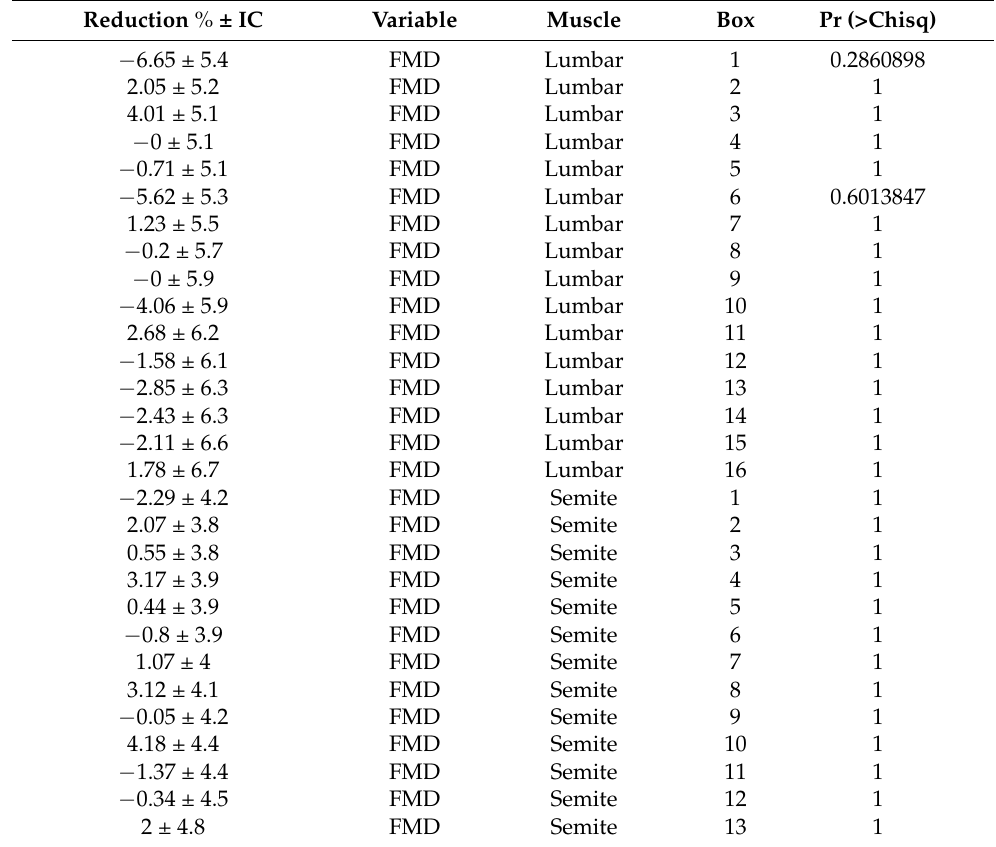
Table A5. The first column includes the percentile of reduction with the confidence interval. The second column shows the variable, in this case, the FMD; the third column, the muscle; and the fourth column, the number of box. Last value contains the p -value of the